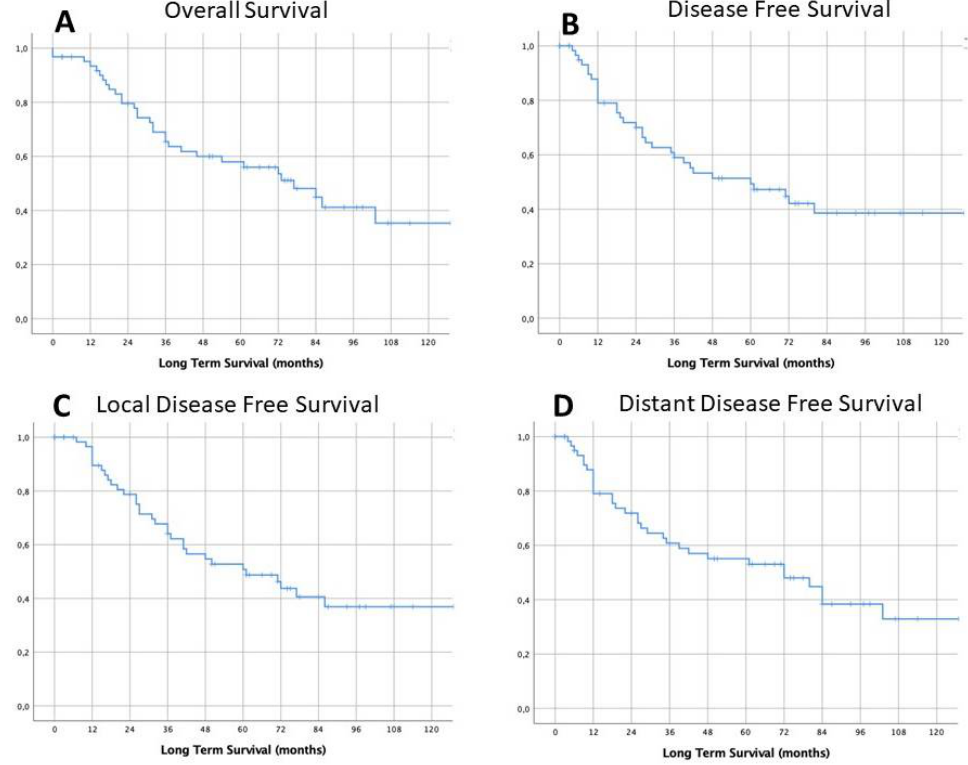
Figure 2. Survival long-term results: overall long-term survival (LTS) ( A ) and overall disease-free survival (DFS) ( B ), and local disease free survival ( C ) and distant disease-free survival ( D